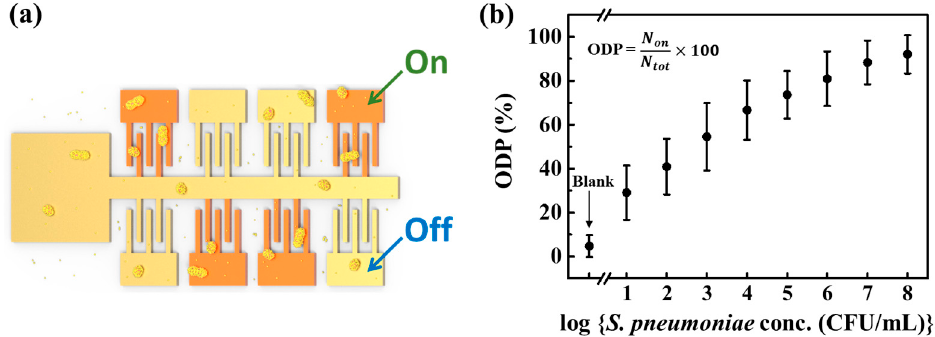
Figure 4. ( a ) The conceptual representation of the detection of bacteria with the use of integrated microgap devices through the nanoparticle decoration method. ( b ) The ODP curve with respect to S. pneumoniae concentration. Error bars represent the 95% confidence intervals.